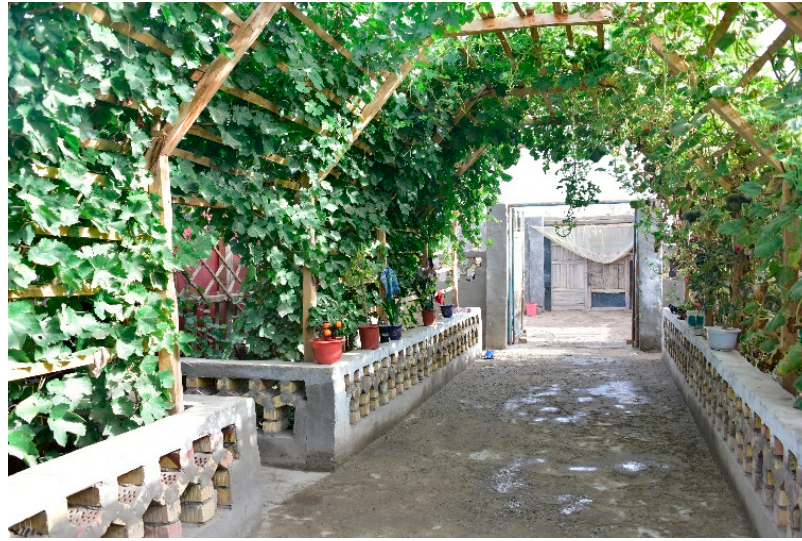
Figure 4. Courtyard economy.